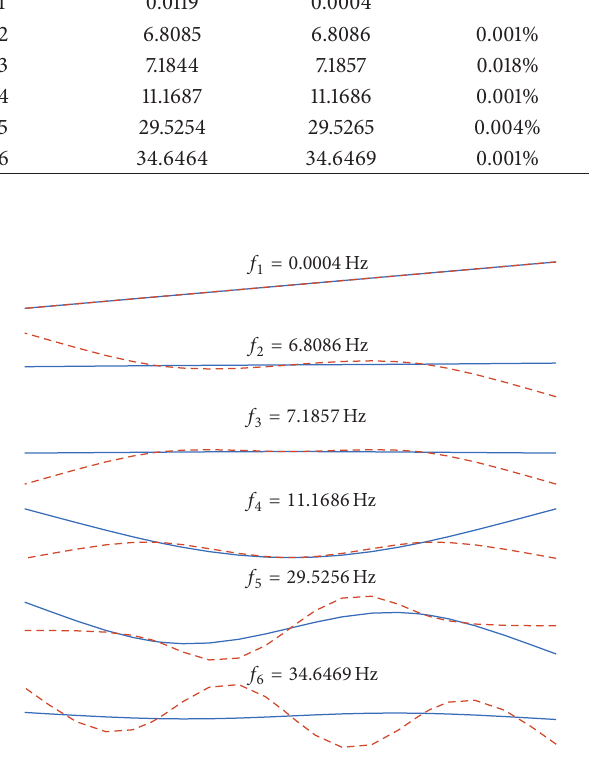
Figure 3: Mode shapes of the free-free double-beam system when using 3 connections.